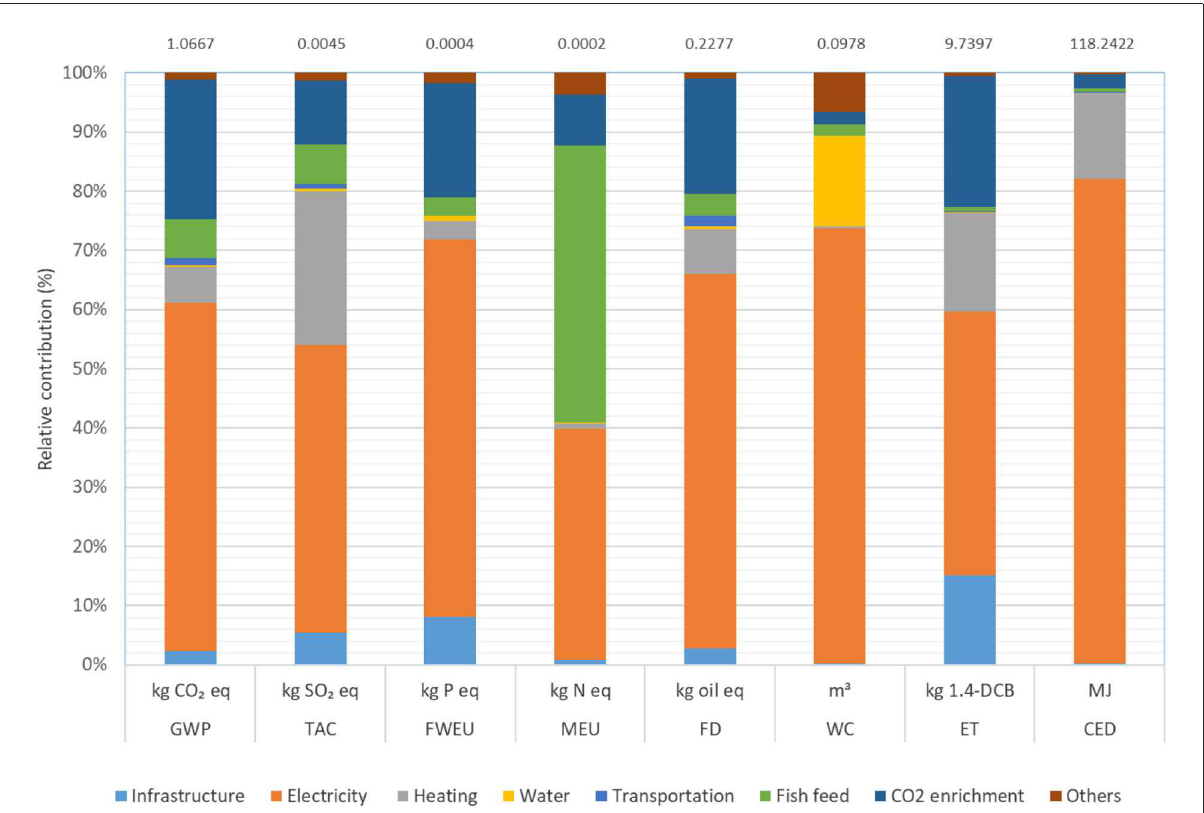
FIGURE2 The overall parameter contributions for each impact category under study. The other parameters include the impacts from input seedlings and fish as well as fertilizers. The transportation parameter excludes transportation of infrastructure and fertilizers as they were included in the Ecoinvent datasets for these processes. The numbers above each bar represent the quantified environmental impact of that category per 1kg of food produced. Data for the figure are provided in Supplementary Table